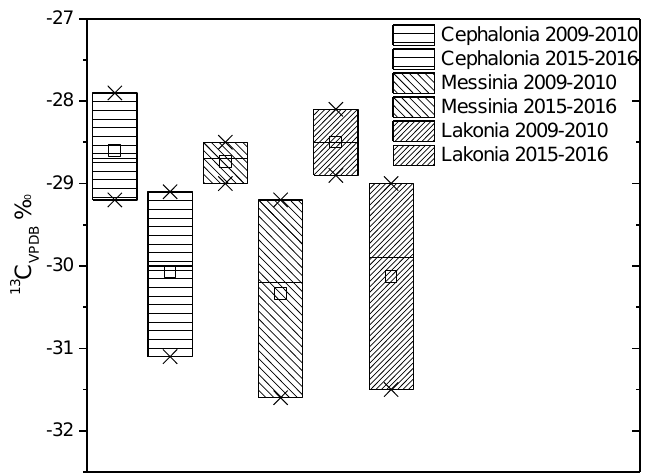
Figure 2. δ 18 O VSMOW of olive oils from Greek areas.